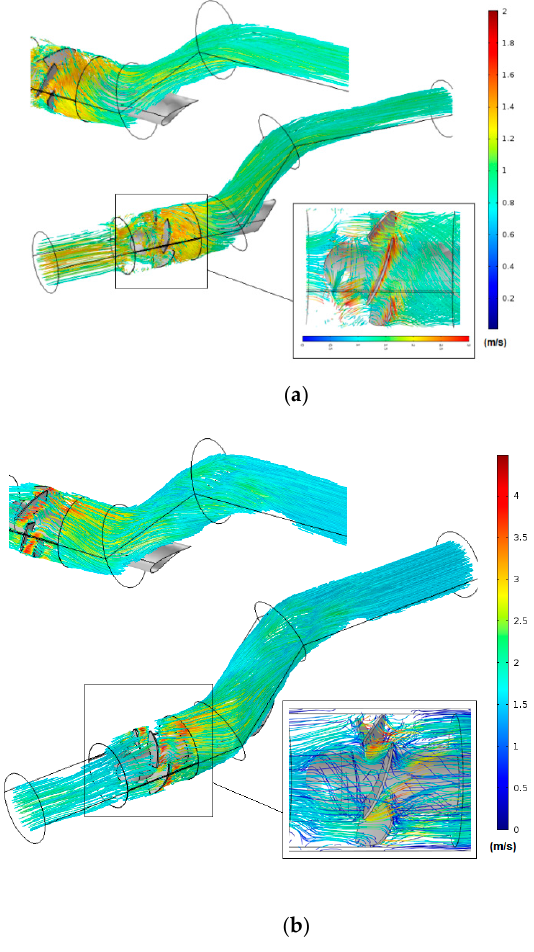
Figure 11. Velocity streamlines for N = 750 rpm: ( a ) D =85 mm; ( b ) D = 170 mm.